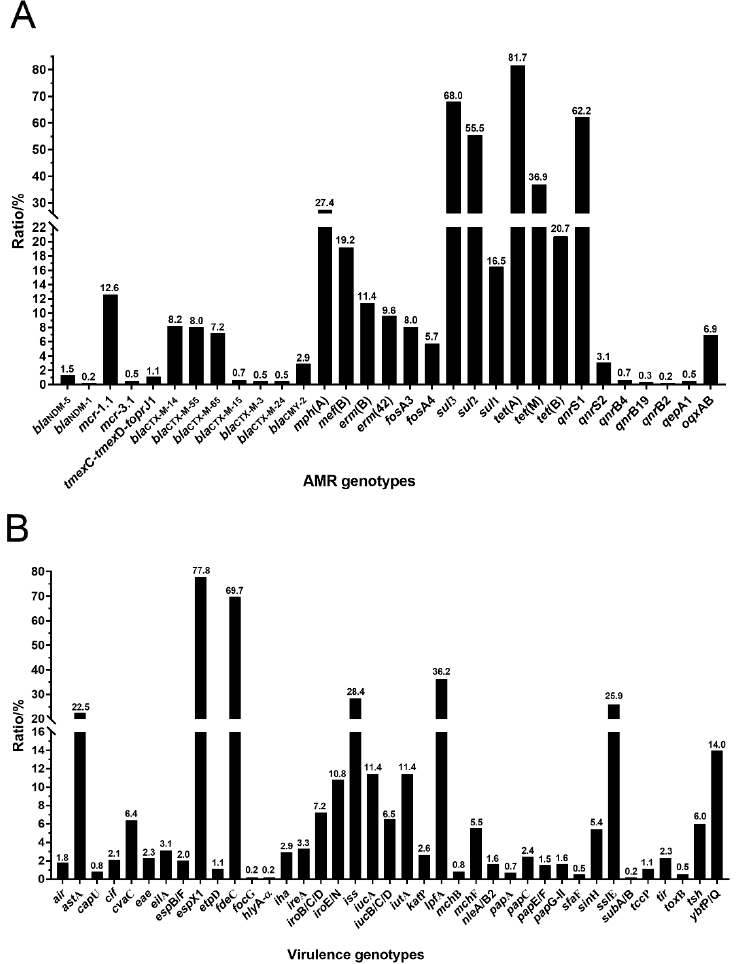
Figure 4. AMR genotypes ( A ) and virulence genotypes ( B ) in tet (X4)-producing E. coli isolates.